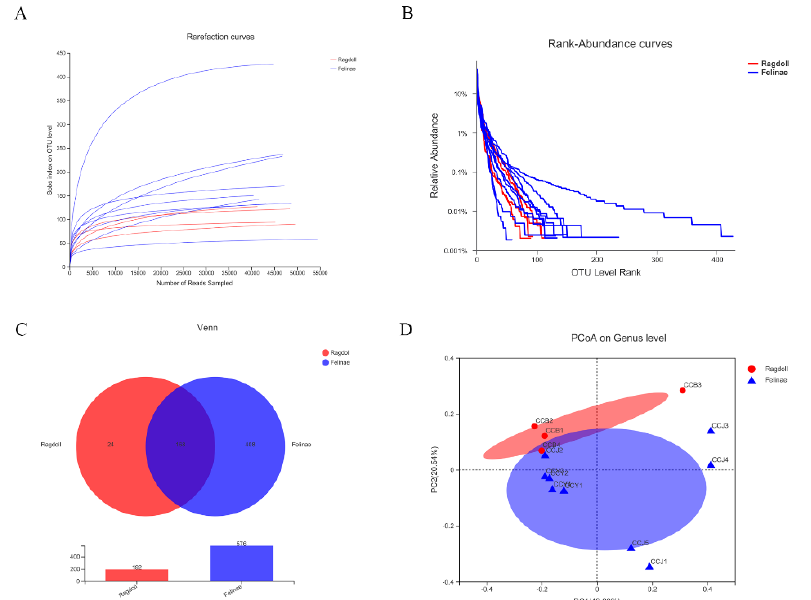
Figure 2. Diversities of the feline gut microbiota. The rarefaction curves ( A ) revealed that the current sequence coverage was adequate for microbial community analysis. The rank–abundance curves ( B ) indicated that the bacterial richness of the Felinae cat group was much higher than that of the Ragdoll cat group. The Venn diagram ( C ) displayed the shared and unique OTUs between the two groups. The plot of principal coordinate analysis (PcoA) ( D ) revealed the beta diversities of the feline gut microbial communities.